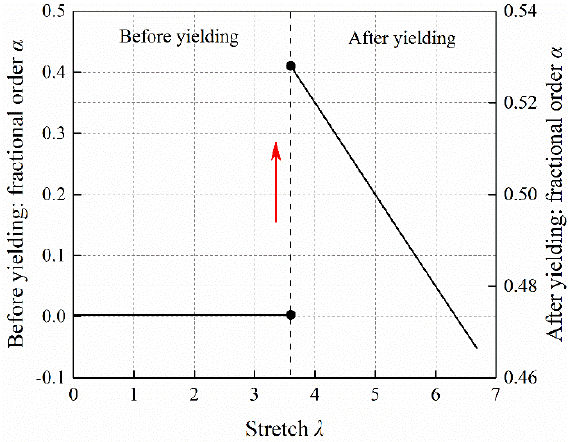
Figure 3. Comparison of the experimental data of soft elastomer at stretch rate 0.065/s and the pre- diction of the discrete fractional model with variable order.